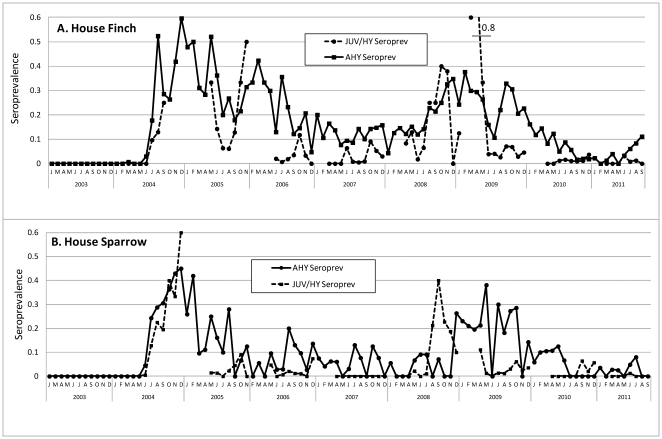
Proportion of after hatching year (AHY) and juvenile/hatching year (JUV/HY) House Finches and House Sparrows positive for antibodies against WNV based on EIA results.Seroprevalence was cumulative and based on all birds regardless of recapture status.